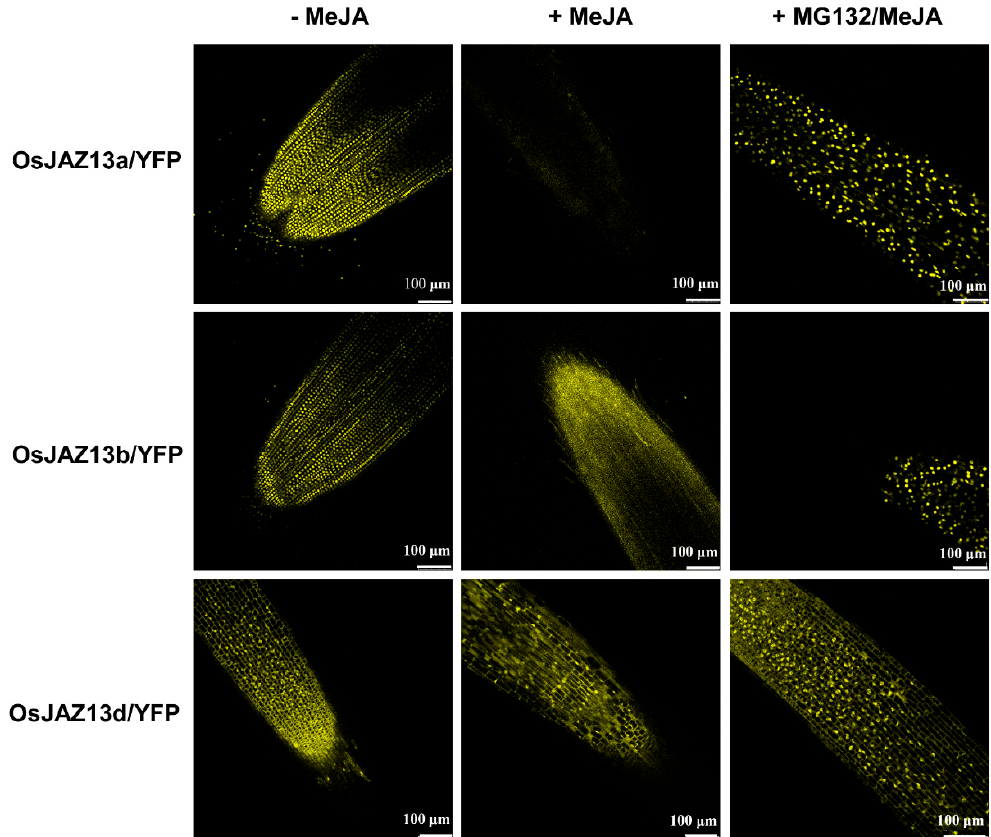
Figure 6. Stability of OsJAZ13 splice variants in vivo. Transgenic rice seedlings expressing Ubi-OsJAZ13a-YFP , Ubi-OsJAZ13b-YFP , and Ubi-OsJAZ13d-YFP grown in 1 / 2MS medium treated with water ( − MeJA) or 50 µM MeJA (+MeJA) for 2 h, or 100 µM MG132 + 50 µM MeJA (+MG132/MeJA) for